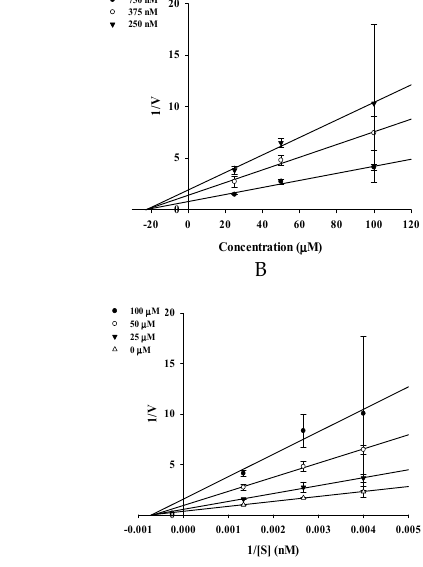
Figure 2. Dixon plots for BACE1 inhibition of 2 ( A ) and 3 ( B ) were tested in the presence of different concentrations of substrate: 750 nM ( ● ), 375 nM ( ○ ), 250 nM ( ▼ ). Lineweaver–Burk plots for BACE1 inhibition of compounds were analyzed in the presence of different concentrations of sample as follows: 0 µ M ( ∆ ), 0.4 µ M ( (cid:72) ), 2 µ M ( ), 10 µ M ( ) for 2 ( C ); 0 µ M ( ∆ ), 25 µ M ( (cid:72) ), 50 µ M ( ), 100 µ M ( ) for 3 ( D